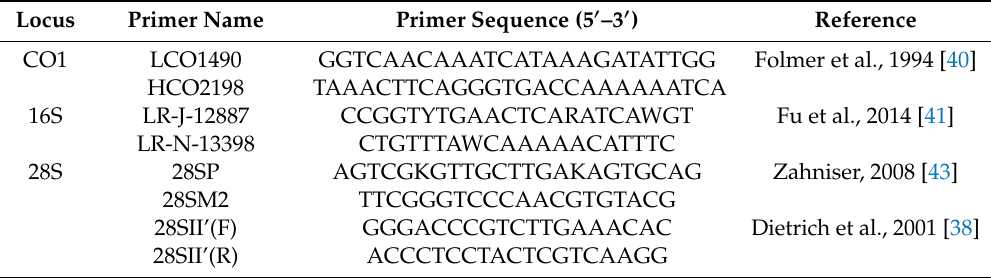
Table 2. Forward (top) and reverse (bottom) primer names, sequences (5 (cid:48) to 3 (cid:48) ) and reference for each primer pair for the mitochondrial CO1 (Cytochrome Oxidase 1) gene, the mitochondrial ribosomal gene16S rRNA and the nuclear 28S ribosomal RNA gene (rRNA).